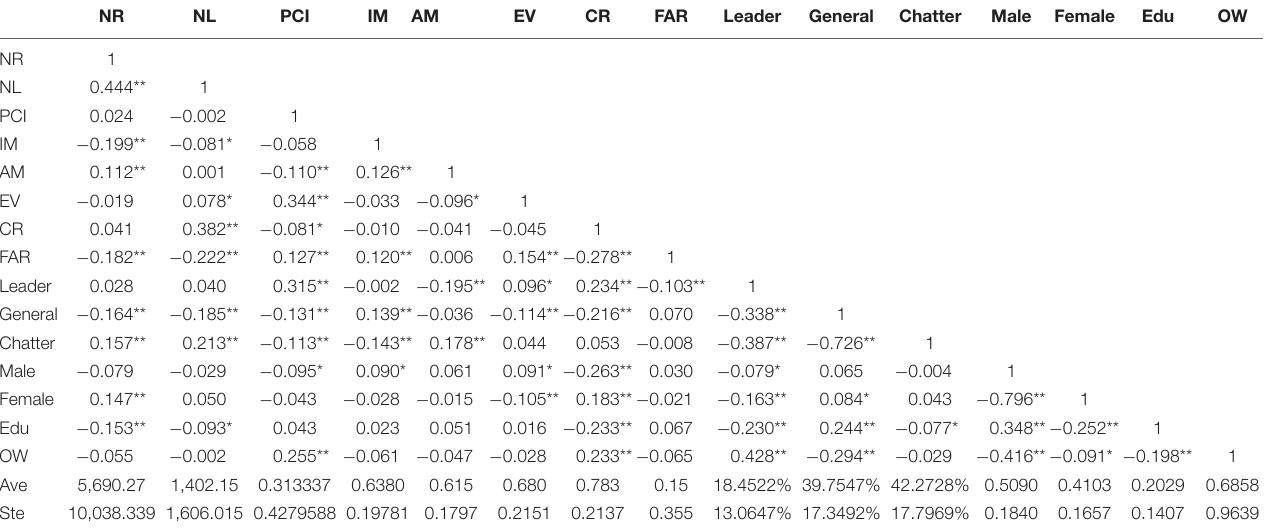
TABLE 7 | Mean, SD, and correlation coefficient ( N = 683).